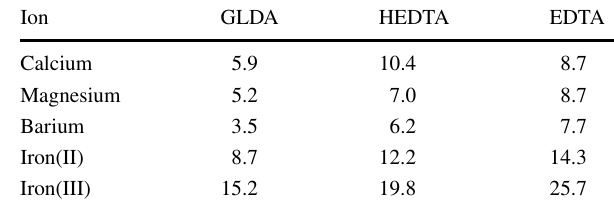
Table 1 Stability constant at 77 °F (Martell et al. 2004; Frenier 2001; Schuler et al. 2002; Kolodynska et al.